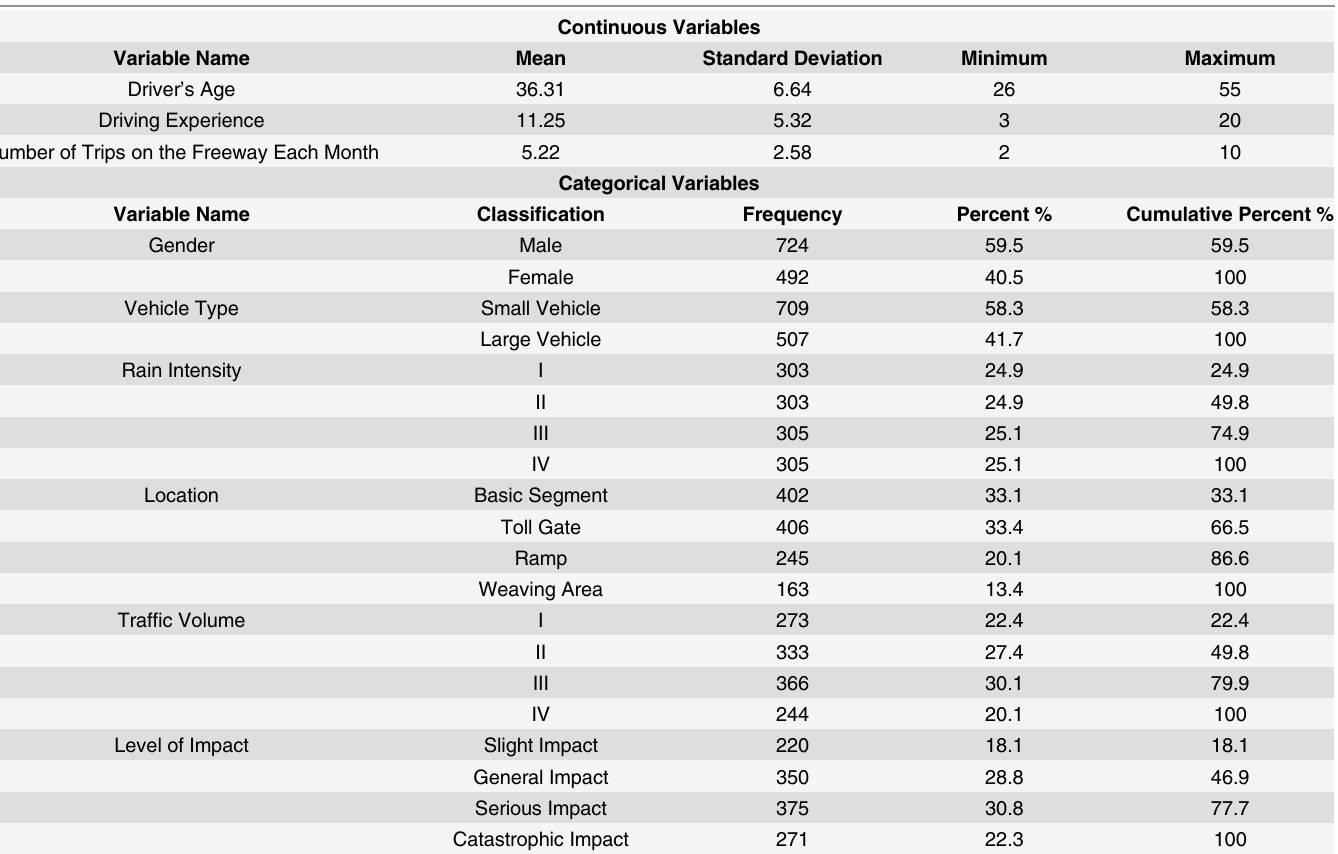
Table 2. Descriptive statistics of the main